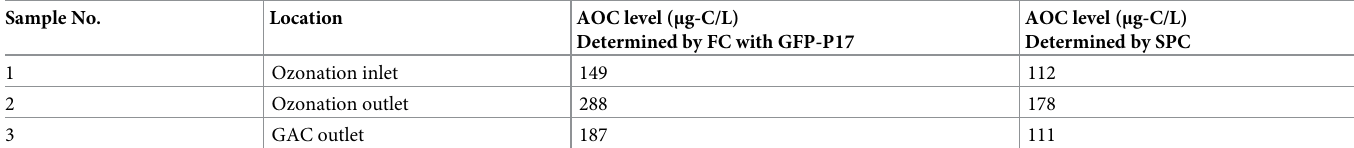
Table 2. AOC concentration measured using flow cytometry (FC) method and spread plate counting method(SPC). Sample